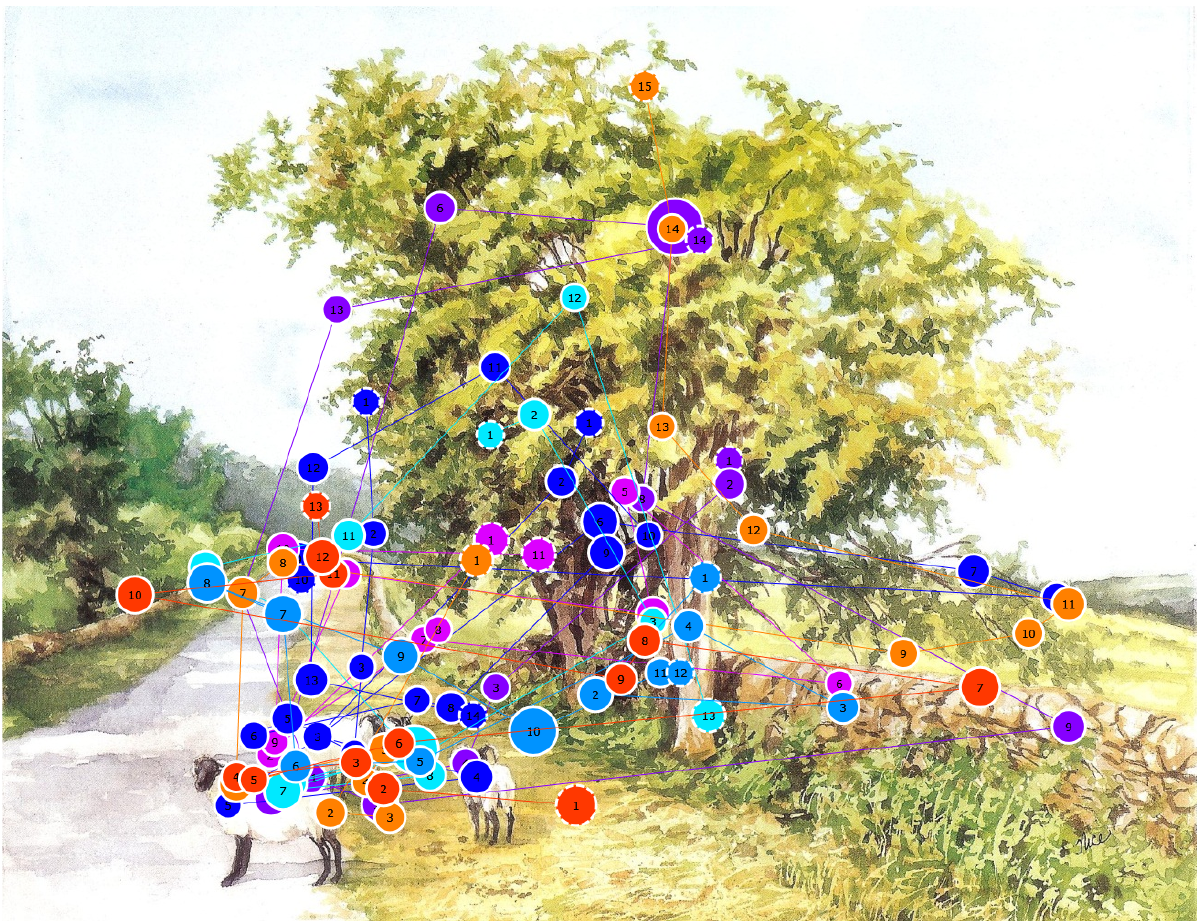
Figures 4b. Gaze plots over Painting 3, Sheep (Source: Nice, 2007)